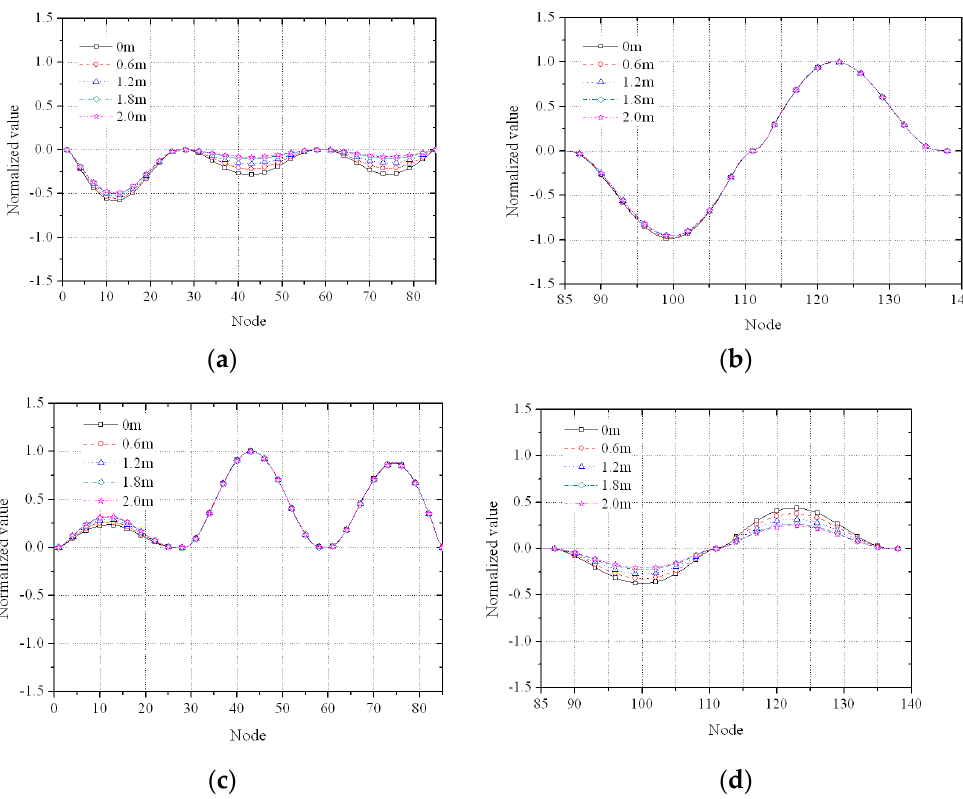
Figure 9. The third and fourth vertical bending mode shapes with different crotch diaphragm stiffness. ( a ) Third mode shape (main bridge); ( b ) Third mode shape (ramp); ( c ) Fourth mode shape (main bridge); ( d ) Fourth mode shape (ramp).